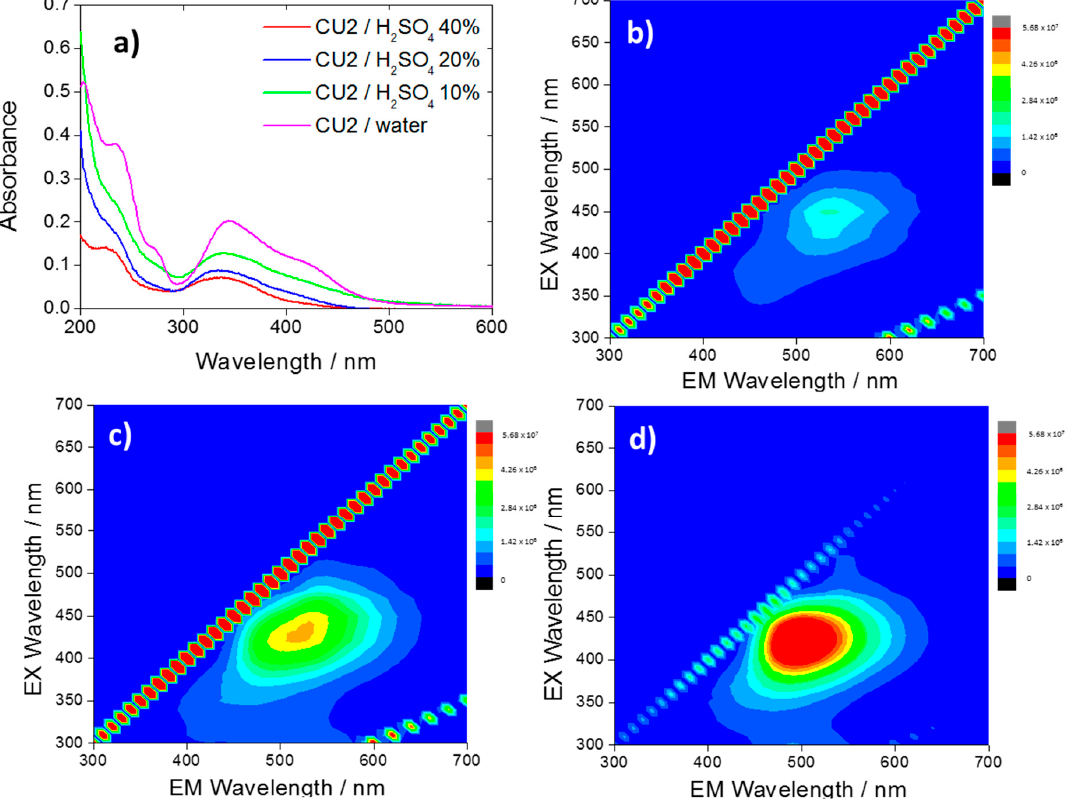
Figure 2. ( a ) UV–Vis spectra of CU2 C-dots in water (10 mg L − 1 , violet) and in sulfuric acid 10% (green), 20% (blue), 40% (red), and 3D photoluminescence spectra (excitation (y-axis), emission (x-axis), intensity (false colors scale)) of the CU2 C-dots in H 2 SO 4 , 40% ( b ); 20% ( c ) and 10% ( d ) C-dots concentration = 10 mg L − 1 .